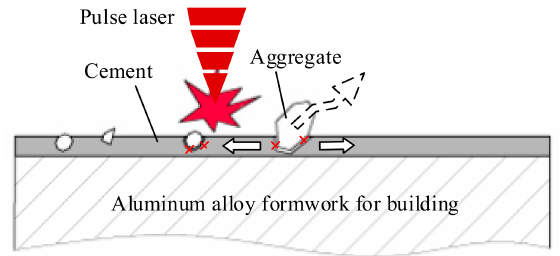
Figure 9. Laser cleaning mechanism of thin concrete slurry